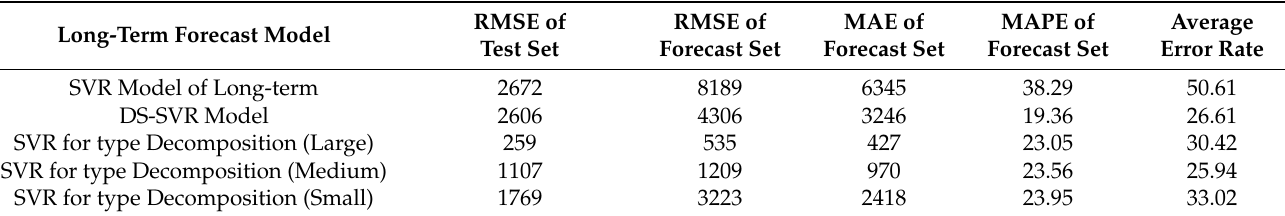
Figure 5. A comparison of long-term prediction errors between the proposed DS-SVR model and the SVR model. Table 6. Forecast results of long-term forecast